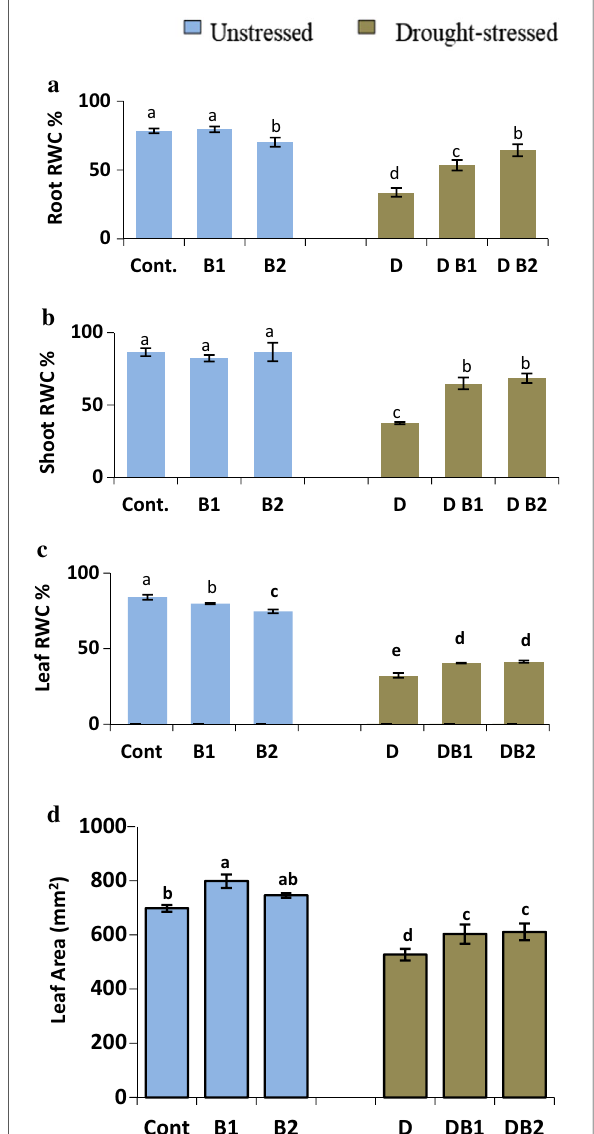
Fig. 2 Effect of bacterial inoculation with Azospirillum brasilense NO40 (B 1 ) and Stenotrophomonas maltophilia B11 (B 2 ) on the RWC% of a roots; b shoots; c the second-node leaf and d leaf area (mm 2 ) of the 15-day-old Triticum aestivum L. seedlings (cv. G9) grown in sandy soil, under unstressed and drought-stressed conditions (7 days of water withholding). Error bars represent the standard deviation between 3 replica. Treatments with identical letters are not significant at P 0.01. Cont. unstressed-uninoculated ≤ ≡ treatment; D drought-stressed-uninoculated treatment; ≡ Fig. 1 Effect of bacterial inoculation with Azospirillum brasilense B 1 and B 2 unstressed-inoculated treatments; DB 1 and ≡ NO40 (B 1 ) and Stenotrophomonas maltophilia B11 (B 2 ) on the DB 2 drought-stressed- inoculated = 15-day-old Triticum aestivum L. (cv. G9) seedlings grown in sandy soil, under unstressed ( a ) and drought-stressed (7 days of water withholding) ( b ) conditions. Cont. the unstressed-uninoculated = control; D the drought-stressed-uninoculated treatment, = B (1–2) the unstressed- inoculated treatments and DB (1–2) the = = drought-stressed-inoculated treatments